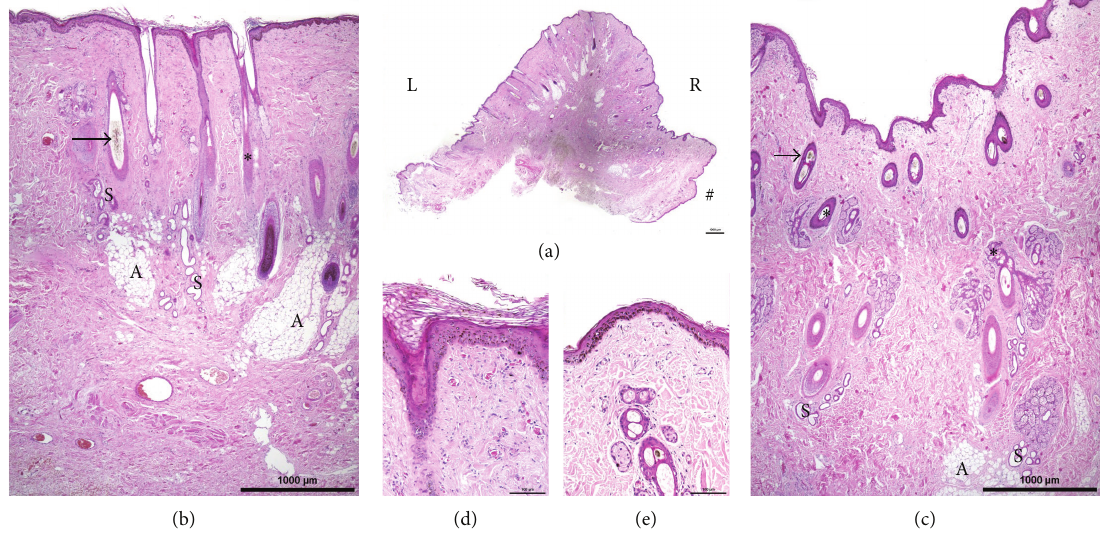
Figure 5: Case 2 histopathological image of excised lesion of OD, showing characteristics of normal skin. (a) At low magnification, it is impossible to differentiate the sample from another skin sample. Note the anatomical continuum from the left (eyelid hamartoma, L) to the right (conjunctival dermoid, R) and the conjunctival margin of the sample (#). Medium magnification shows pilosebaceous structures ( ∗ ) with hair shafts ( → ), sweat glands (S), and adipose lobules (A) on the cutaneous side (b) and conjunctival side (c) of the dermoid. High power aspect highlights differences between the keratinized epidermis (d) and the smooth, non-, or slight-keratinized thinner epidermis of the conjunctival side (e). Haematoxylin and eosin staining. Original magnification × 10 (a), × 40 (b, c), and × 200 (d, e).